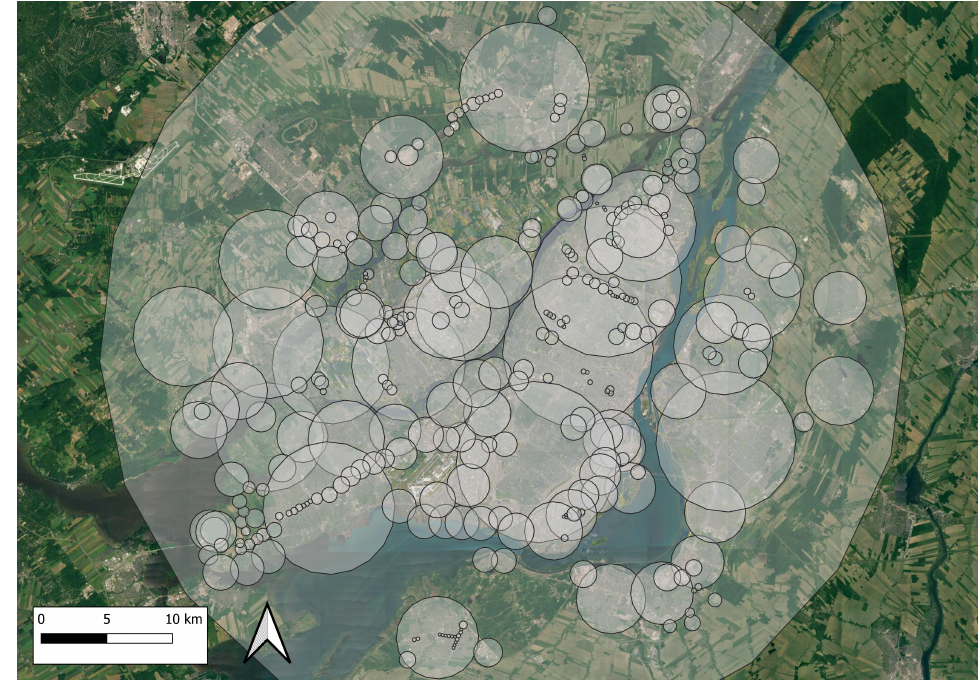
Figure 5. Map of the 309 zones established for the characterization of the lamps height and obstacles properties in Montréal. The complete characteristics of each zone is given in Table